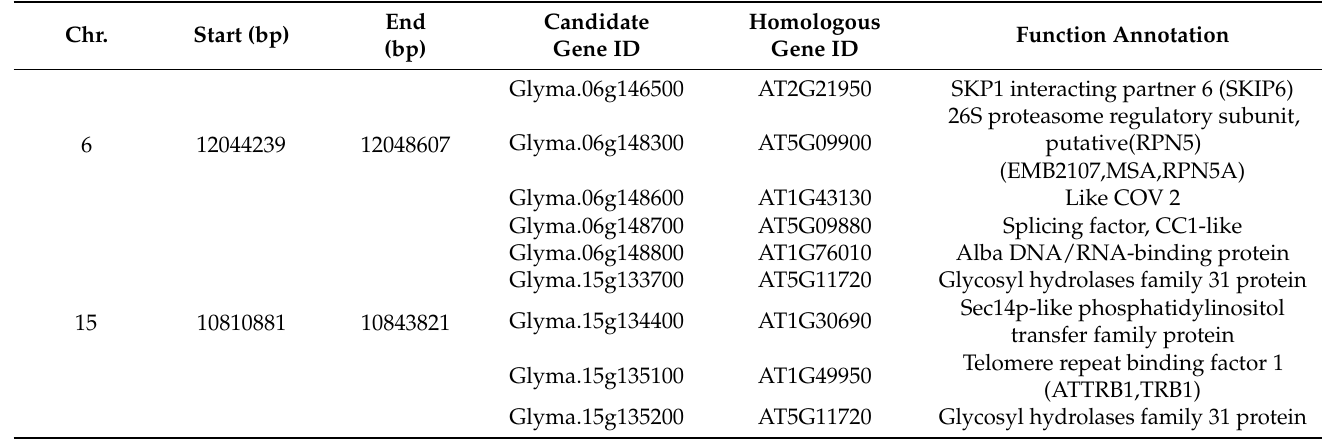
Table 2. Candidate genes for the total soluble